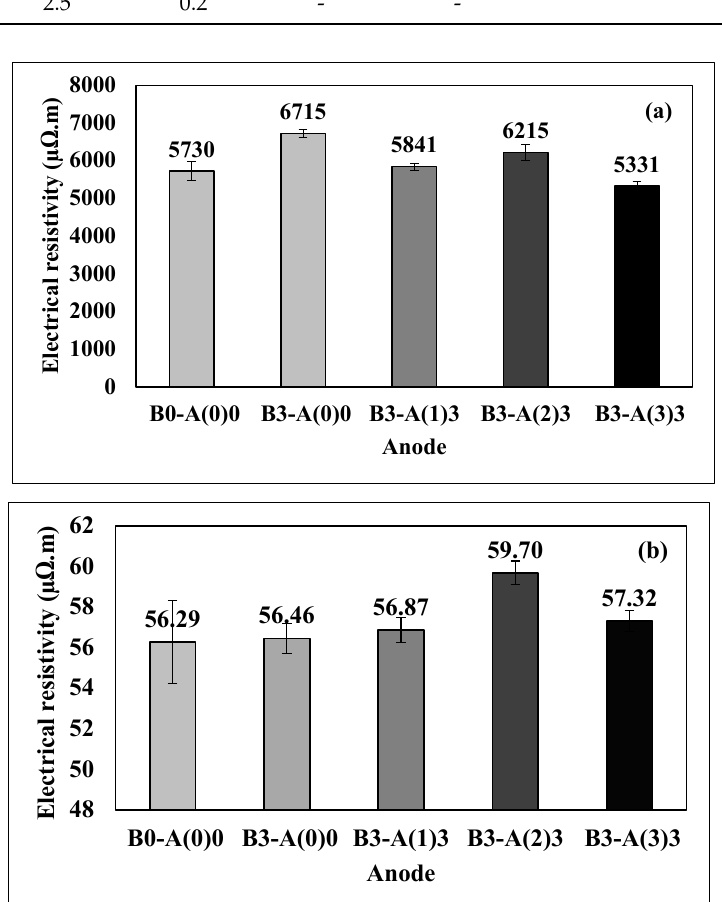
Figure 3. Electrical resistivity of the anodes before ( a ) and after ( b ) baking.